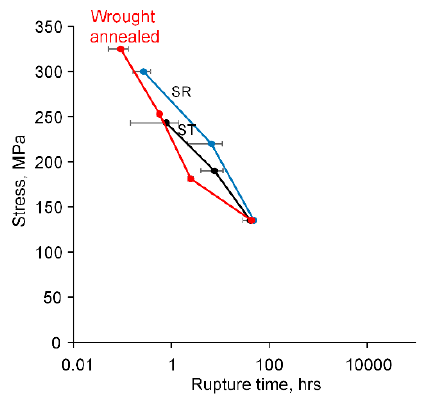
Figure 11. Applied stress versus creep rupture time at 760 °C for the SR, ST, and wrought annealed IN625 alloys.